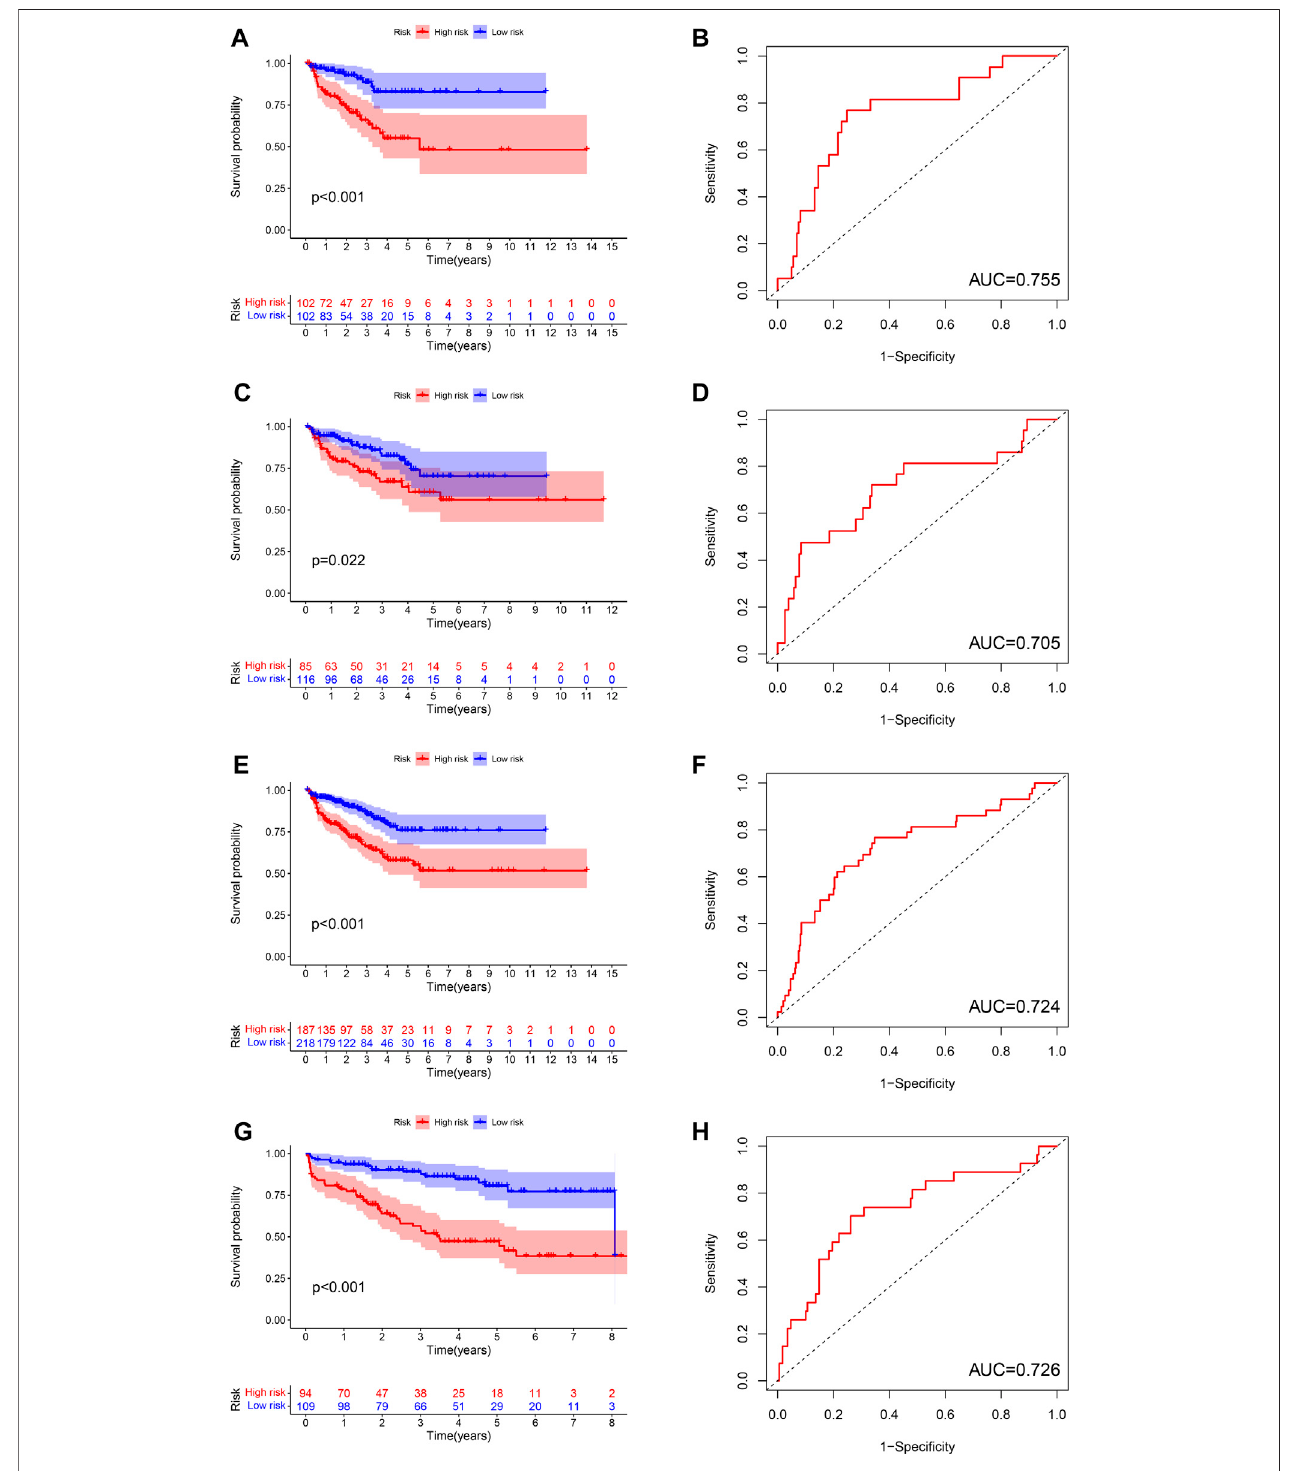
FIGURE 6 | The survival analysis between high and low risk group, and corresponding area under ROC curve in training cohort (A,B) , testing cohort (C,D) , whole TCGA cohort (E,F) , and validating cohort (G,H) .